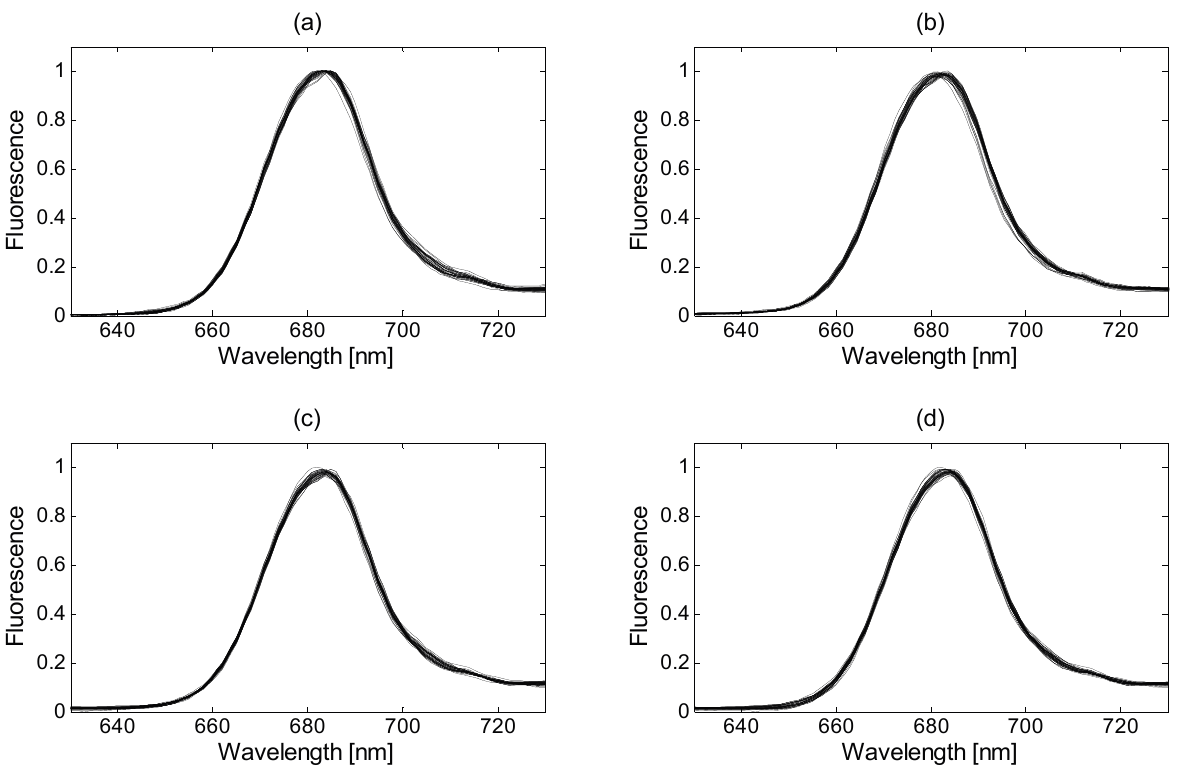
Figure 8. Normalizations applied on the denoised Thwi measurements (with wavelet method and soft threshold) using: ( a ) the min-max method; ( b ) the growing spectra modeling (GSM) method; ( c ) the standard normal variate (SNV) method; ( d ) the modified scale-based normalization (SBN)